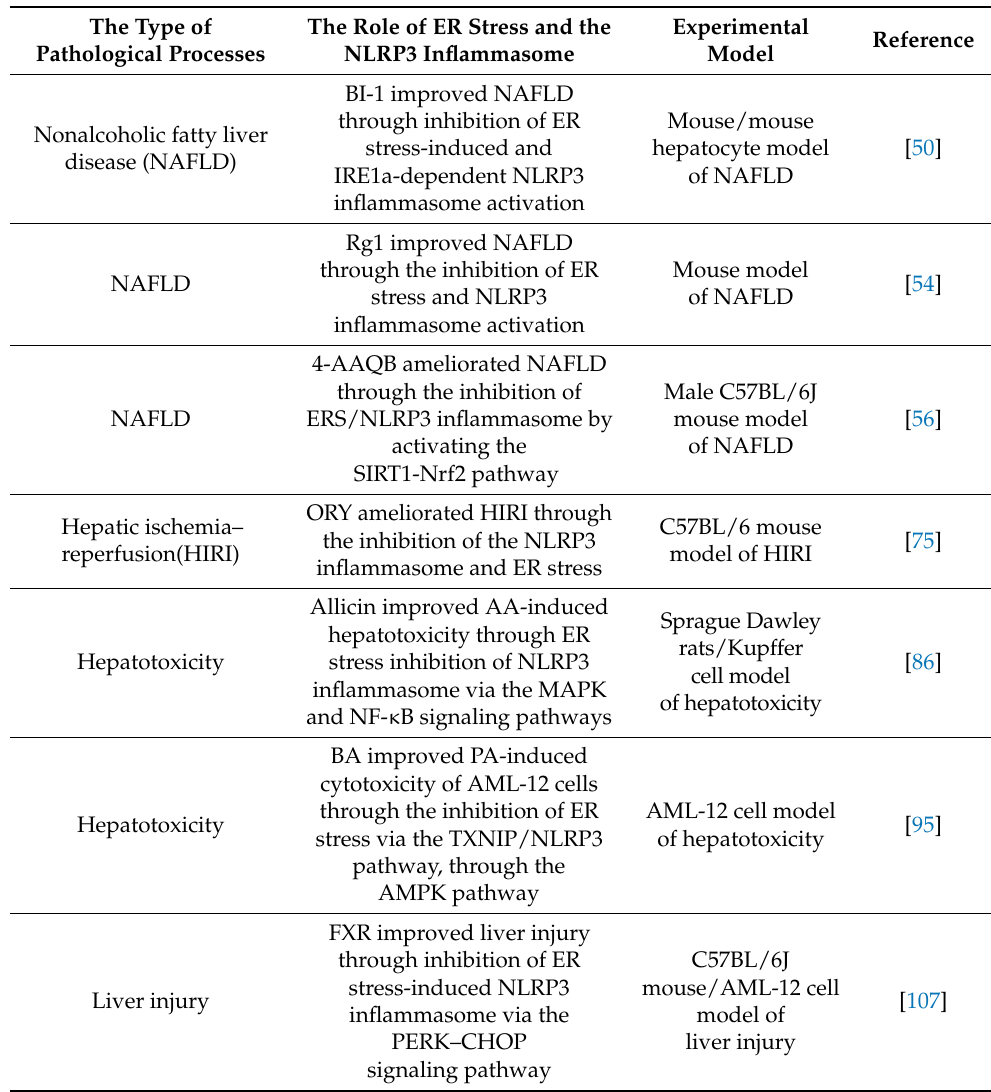
Experimental Model